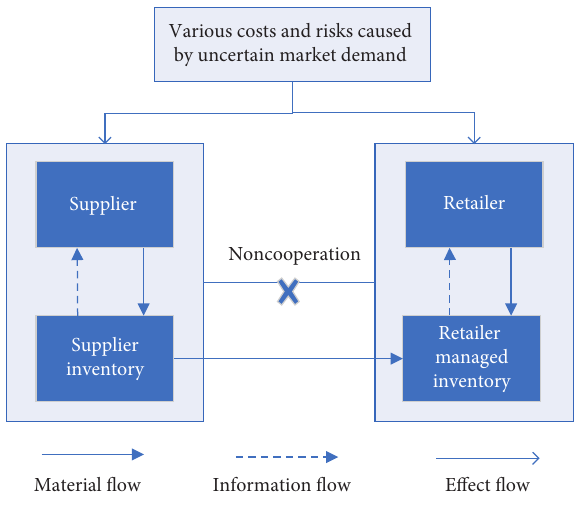
Figure 1: Schematic diagram of RMI mode. Table 1: The recently updated forecasts for world Gross Domestic Product (GDP) and